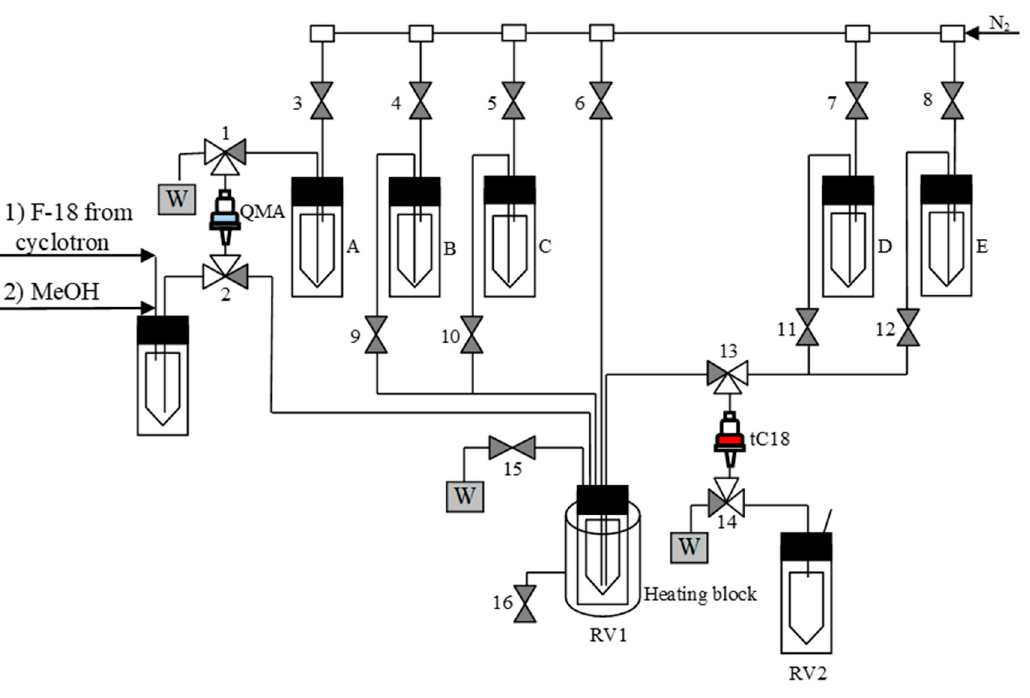
Figure 6. Process flow diagram (PFD) for the semi-automated radiosynthesis of [ 18 F] 2 – 10 . A: a solution of precursor in MeOH/DMF (0.12/0.5 mL); B: H 2 O (4 mL); C: 12 N HCl (0.5 mL); D: H 2 O (5 mL); E: